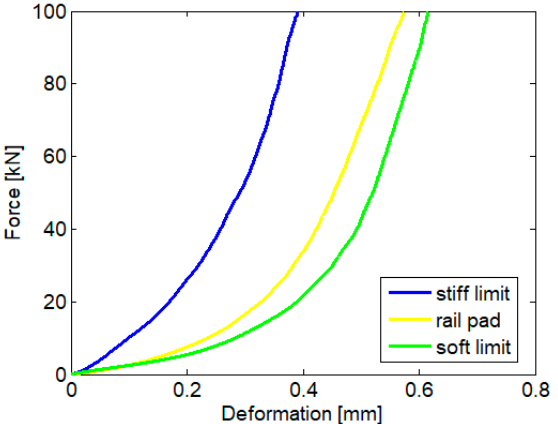
Figure 3. Load-deformation characteristics of a rail pad and the limit characteristics [39].